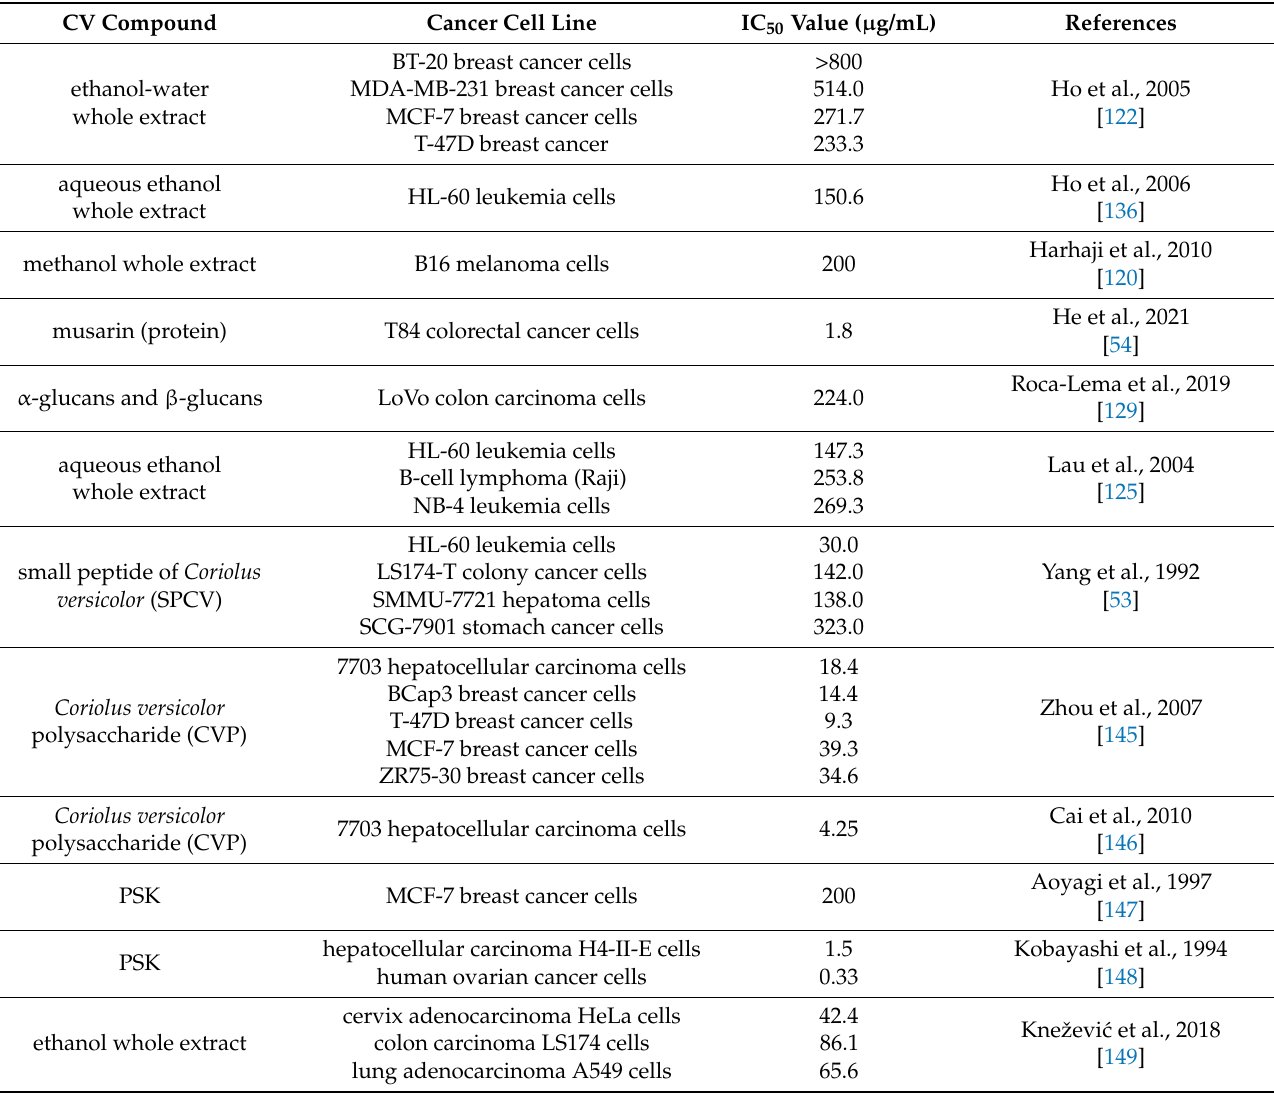
Table 1. IC 50 values of different cancer cell lines stimulated with the whole CV extract or its com-